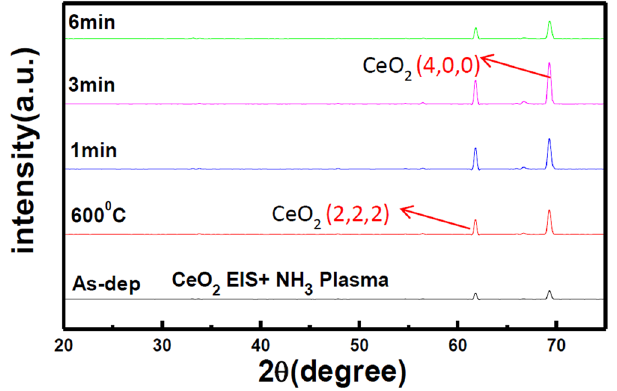
Figure 3. XRD of ( a ) CeO 2 samples with NH3 plasma treatment in various conditions. ( b ) Ce 2 Ti 2 O 7 samples with NH3 plasma treatment for 3 min.